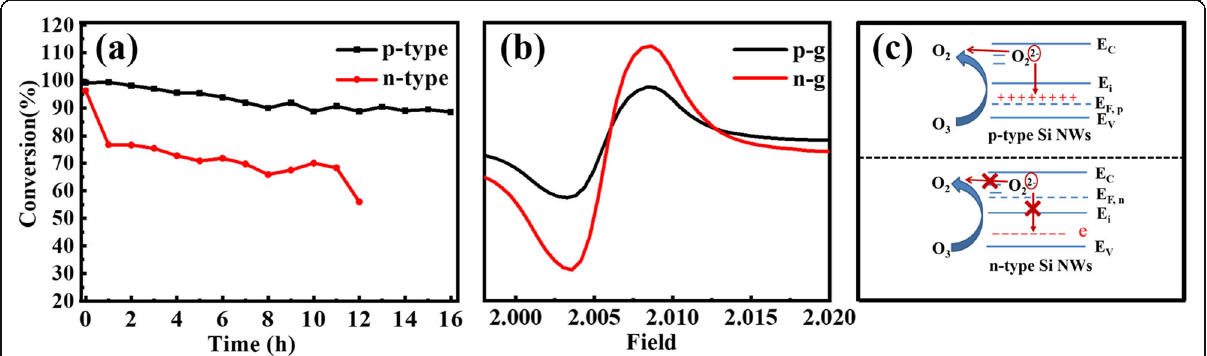
Fig. 3 a The conversion of ozone using p- and n-type Si NWs as catalysts; b EPR detection of p- and n-type Si NWs; and c Schematic comparison of p- and n-type Si NWs. P-type Si is lack of electrons and has positively charged holes, and thus, the release of electron and desorption of O 22 − is easier than the case of n-type